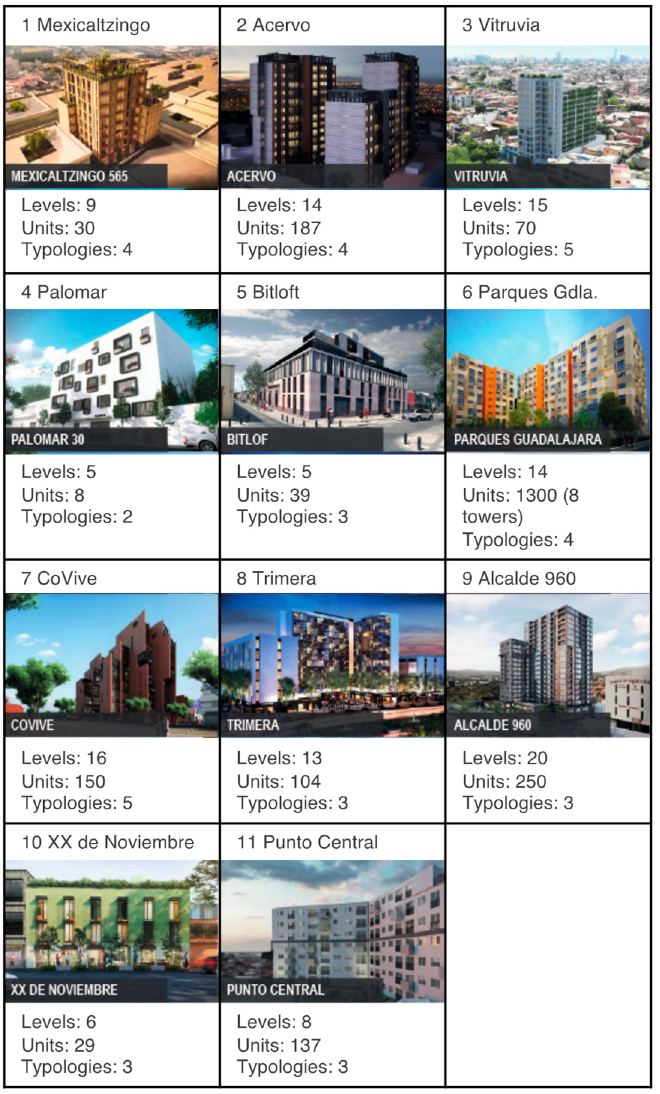
Figure 6. Basic information about the eleven study cases, showing, for each of them, a real estate image, building levels, total number of housing units and number of different housing typologies in the building. Source own elaboration.